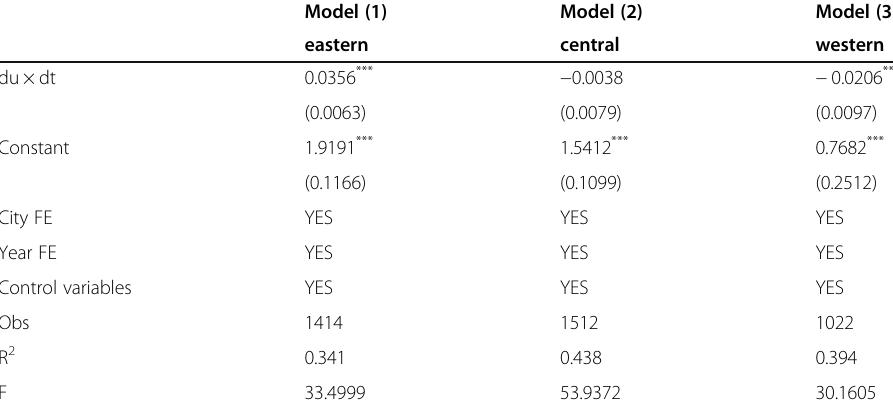
Table 6 Regression test results in the eastern, central and western regions Model (1) Model (2) Model (3) eastern central western du × dt 0.0356 *** − 0.0038 − 0.0206 ** (0.0063) (0.0079) (0.0097) Constant 1.9191 *** 1.5412 *** 0.7682 *** (0.1166) (0.1099) (0.2512) City FE YES YES YES Year FE YES YES YES Control variables YES YES